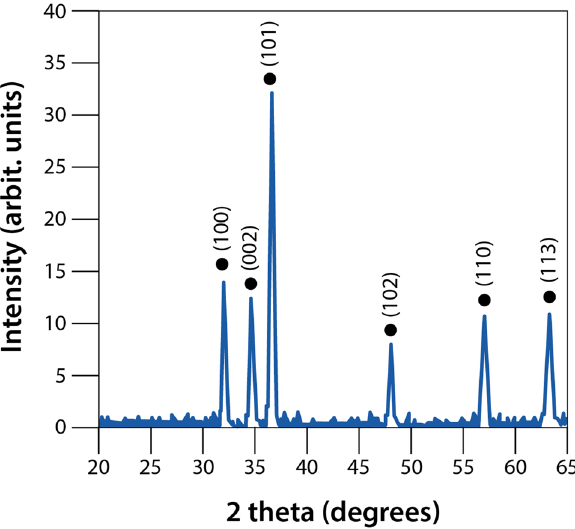
Figure 1. XRD power of ZnO NPs.